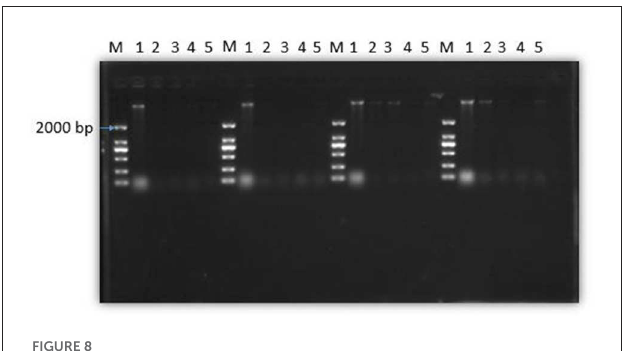
FIGURE8 Agarose gel electrophoresis of DNA from bacterial cells treated by SEDQS. M: Mark; 1: untreated group; 2: 1/4 MIC, 3: 1/2 MIC, 4: MIC, 5: 2 MIC treated group after 30, 60, 90, and 120min.